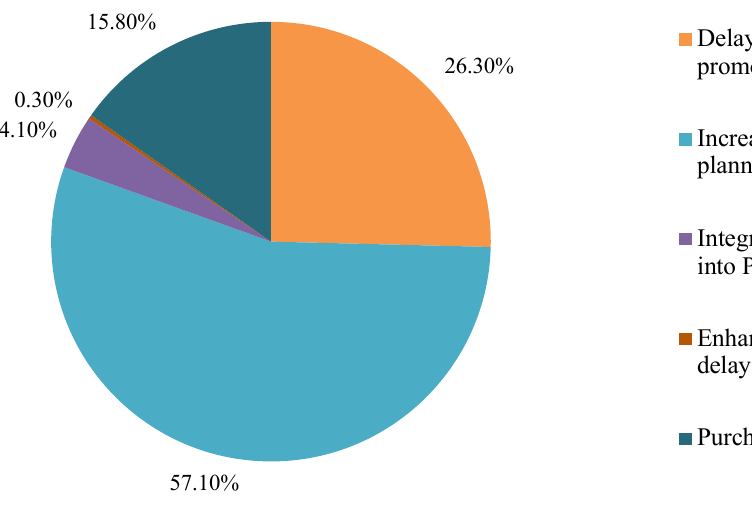
Figure 3. Distribution of funds by priority action area, Costed Implementation Plan for Family Planning,